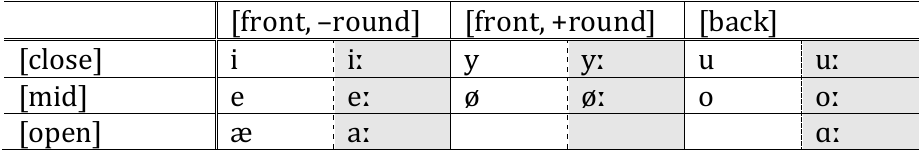
Table 6: The monophthongs of Old English.